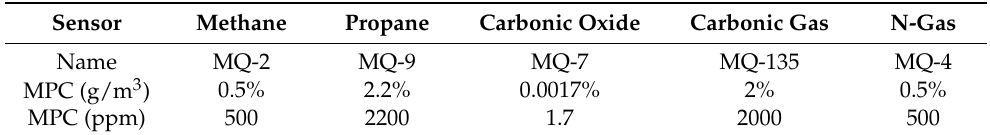
Table 3. Basic parameters of